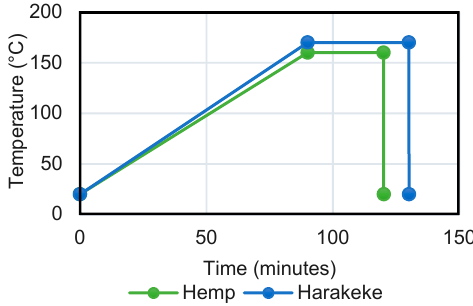
Figure 1. Temperature profile for natural fiber alkali treatment.